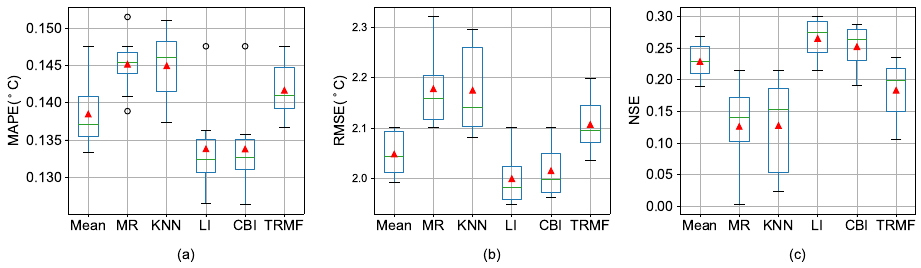
Figure 8. Comparison of prediction accuracy using different filling data in the deep learning model. ( a ): The comparison of RMSE. ( b ): The comparison of MAPE. ( c ): The comparison of